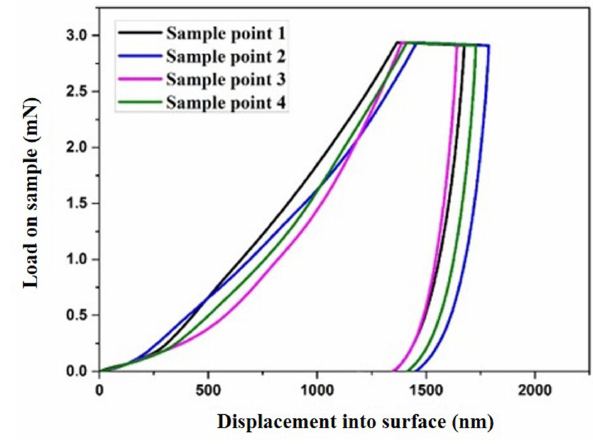
Figure 6: Typical load-displacement curves of EP/CNF-MoS 2 speci- men (the maximum indentation load is 3mN)